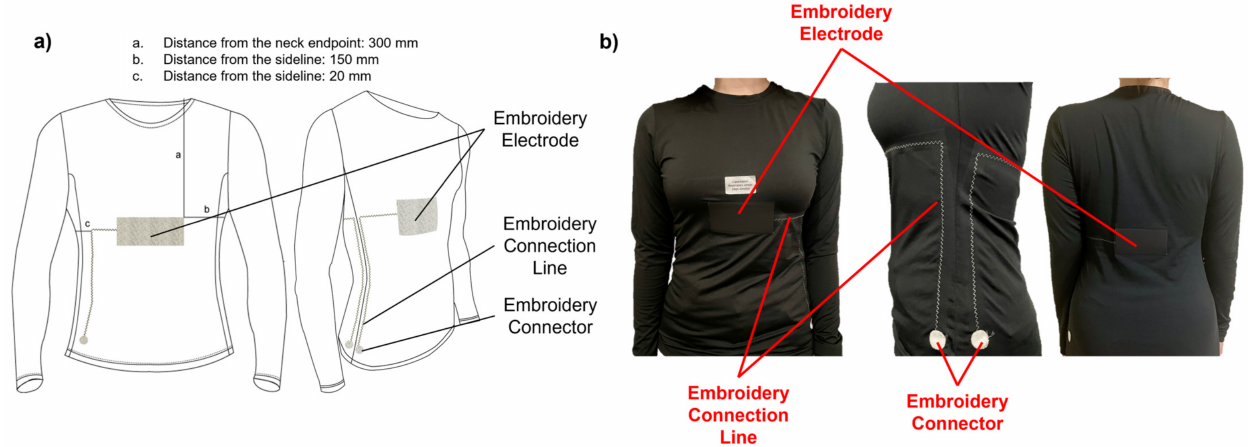
Figure 10. A respiratory sensor in the shape of a finished garment: ( a ) schematic; ( b ) actual